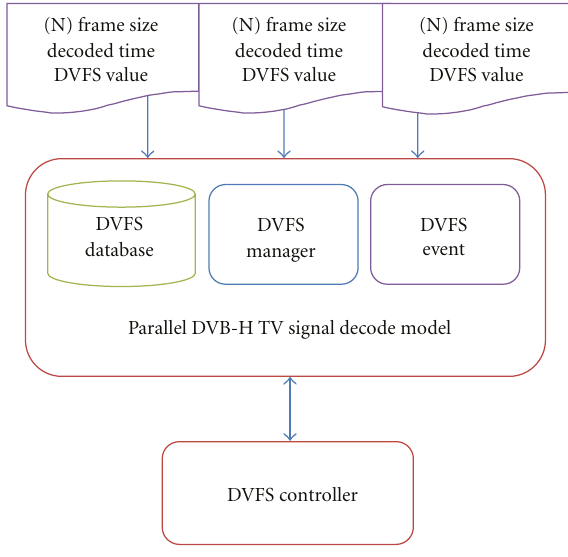
Figure 12: Prediction Mechanism for DVFS. Table 1: Testing